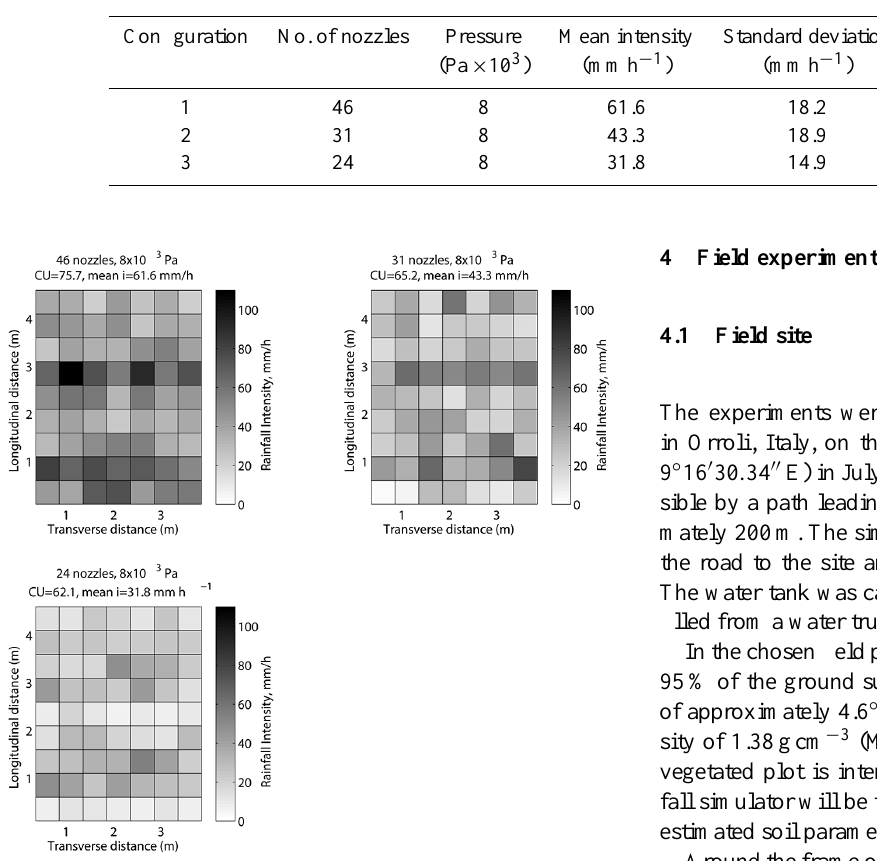
Table 1. Summary of nozzle configurations and performance.